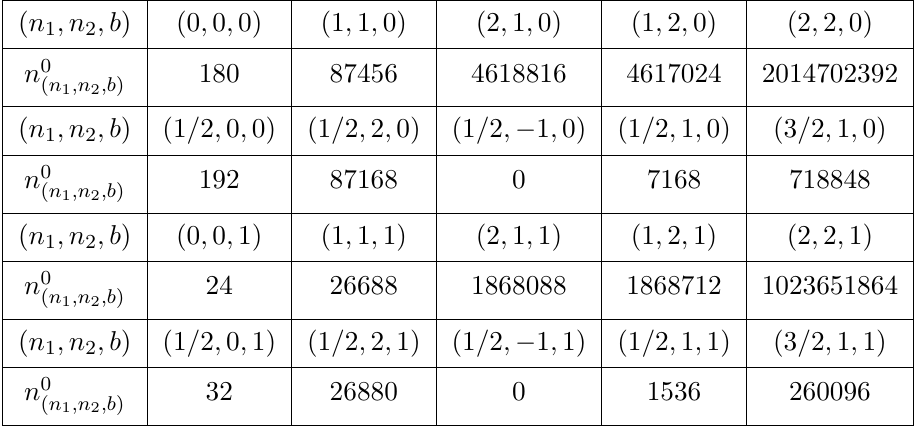
Table 10 . 2 A orbifold, non-standard embedding, with single Wilson line. Shift is given by, (cid:13)